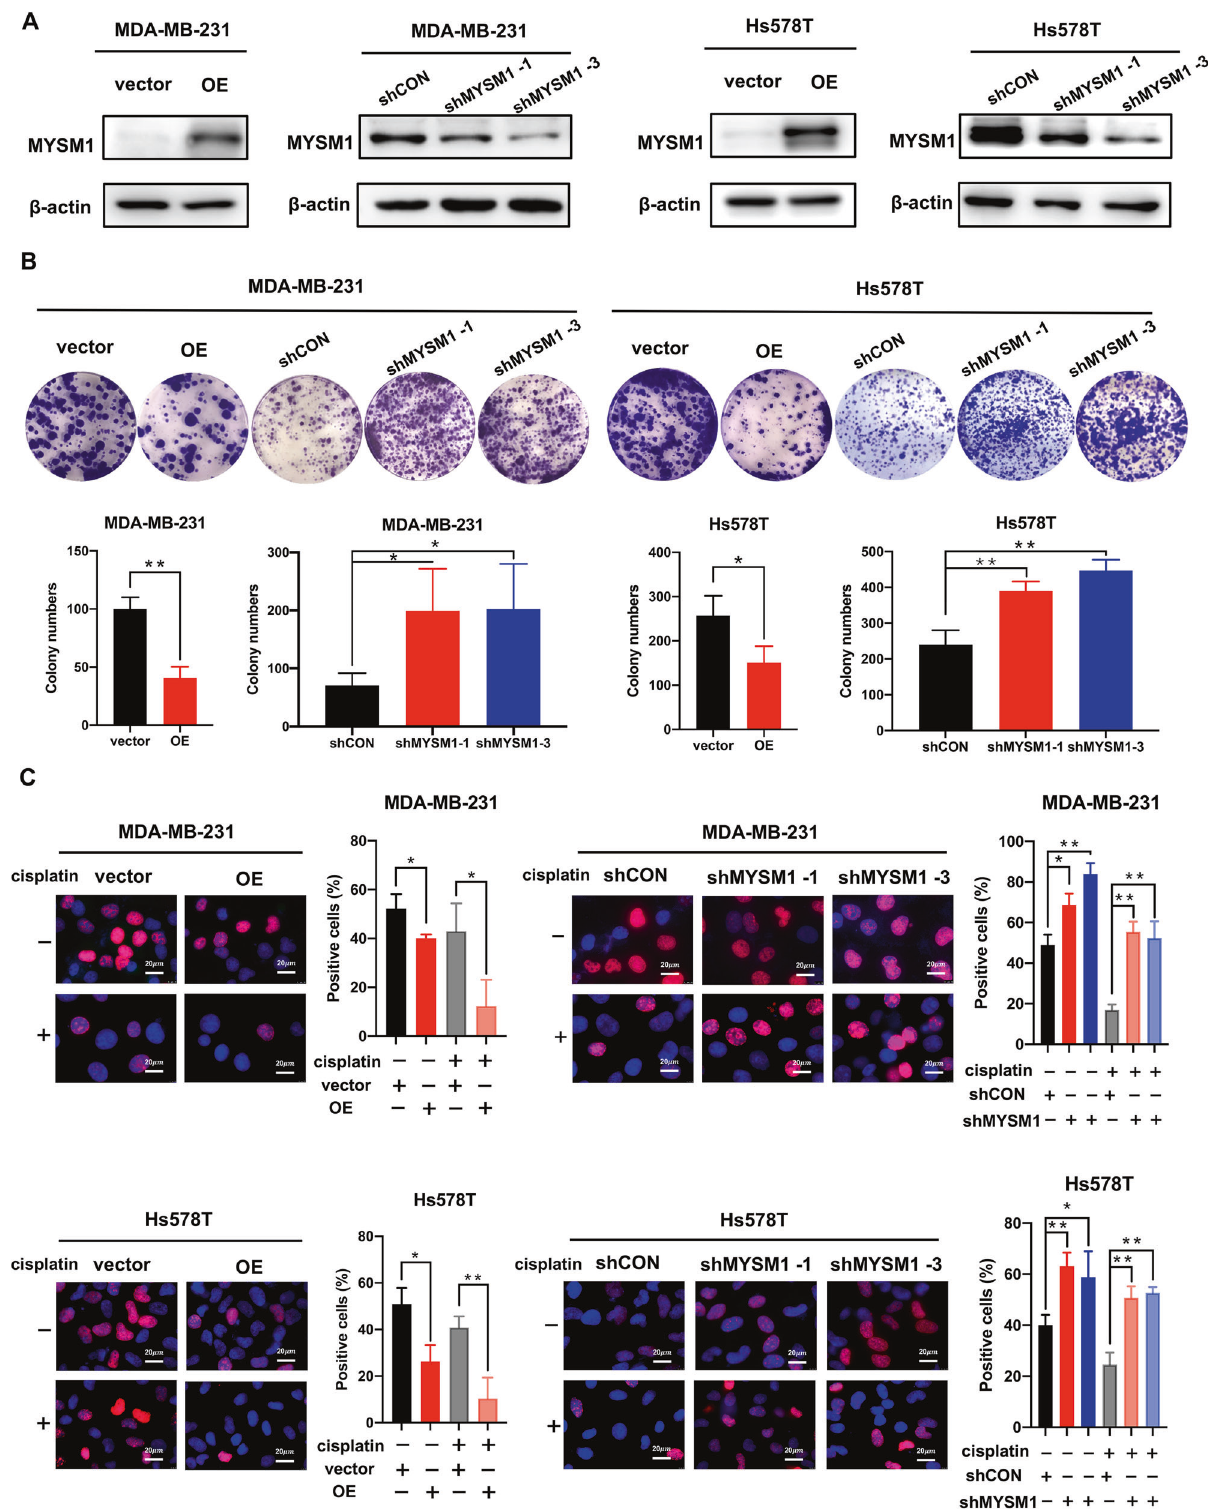
Fig. 2 MYSM1 suppresses cell proliferation, and the suppressive effect is reinforced by cisplatin treatment. A MYSM1 protein levels in MDA-MB-231 and Hs578T cells with stable MYSM1 overexpression and knockdown and their corresponding negative control cells were detected by western blot. B Colony formation assay was performed in MDA-MB-231 and Hs578T cells with stable MYSM1 overexpression and knockdown and their corresponding negative control cells. C MDA-MB-231 and Hs578T cells with MYSM1 overexpression and knockdown, and their corresponding negative control cells were treated with or without cisplatin (5 µg/mL) for 48 h, followed by the determination of cell proliferation via EdU incorporation. Scale bars: 20 μ m. All data in the graph bars represent means ± SD. * P < 0.05 and ** P < 0.01.